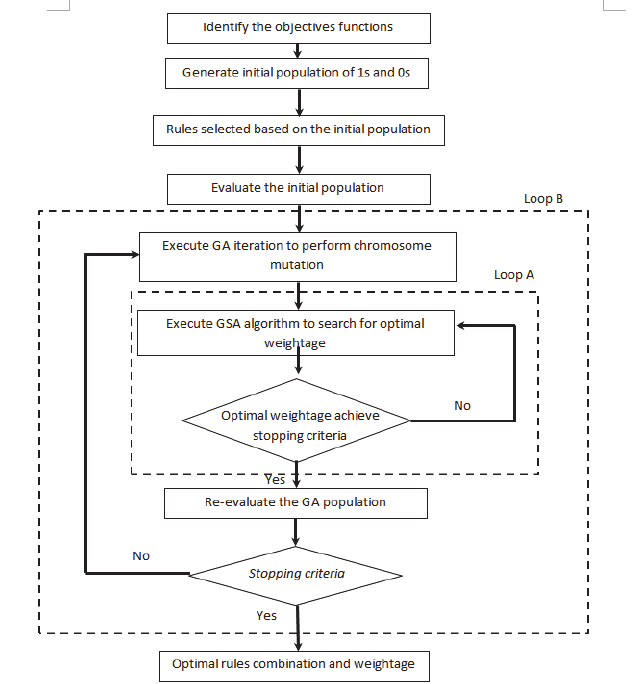
Fig. 2. The flow of the proposed algorithm Expected processing time for 10 jobs in 3 stages Stage 1